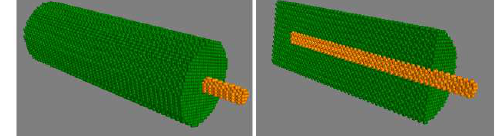
Figure 2. 3D models (cross section on right) of the simulated fibre (orange) embedded in a matrix (green), particle diameter =